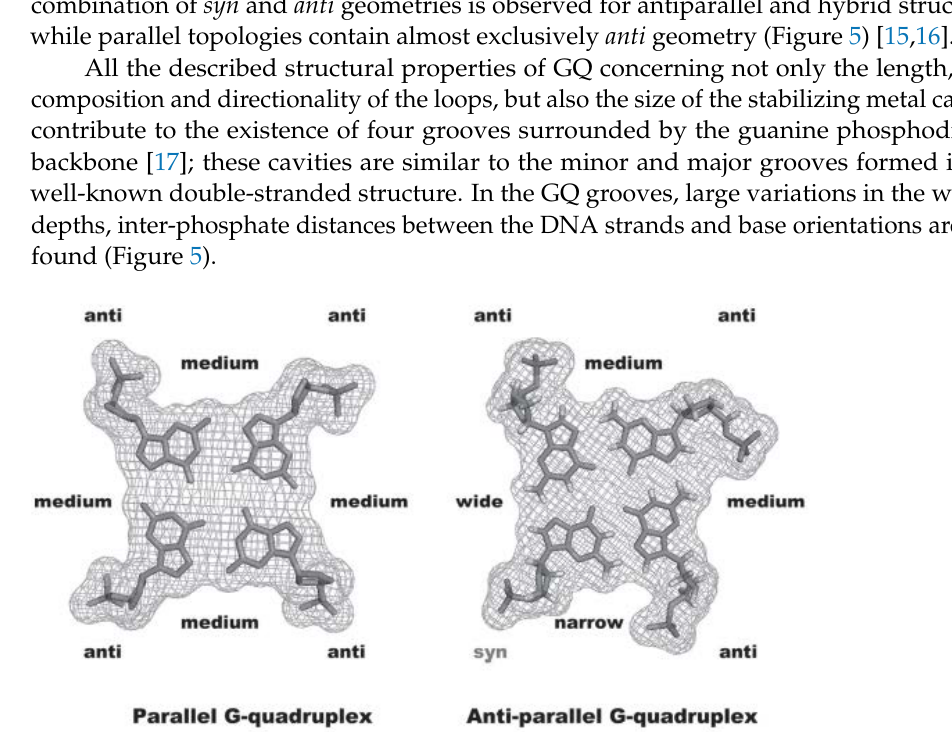
Figure 5. Anti and syn conformation of glycosidic torsion angles and groove sizes of parallel and anti-parallel GQ structures, (figure reused from [18], with permission from John Wiley and Sons.